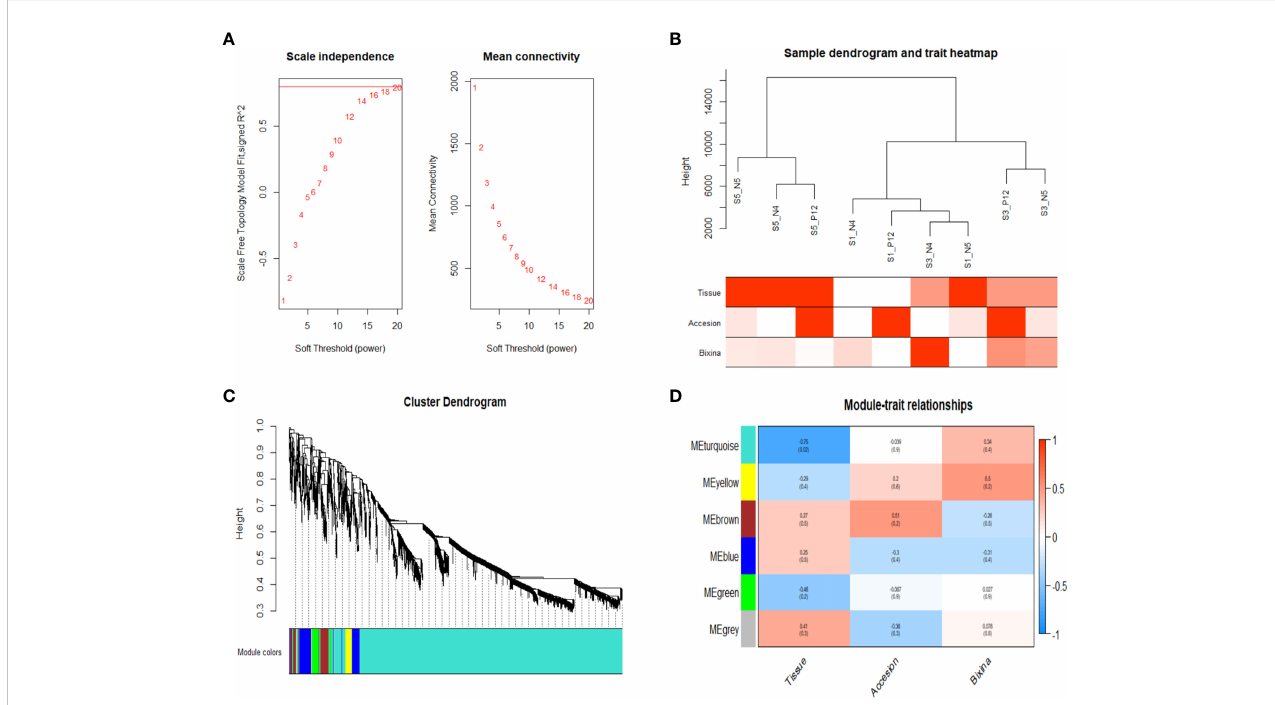
FIGURE 3 WGCNA showed genes highly related to bixin content. (A) Scale independence and average connectivity. (B) Clustering dendrogram of 9 samples. Phenotypic traits were categorized in red intensities by the numbers2colors function showing a high bixin accumulation in S3 of the N4 accession. (C) Dendrogram showing the turquoise module as the largest. Each branch represents a gene, and each color represents a co-expression module. (D) Heatmap of the correlation between module eigengenes and phenotypic characteristics showing the yellow and turquoise modules as the highest correlated with the bixin